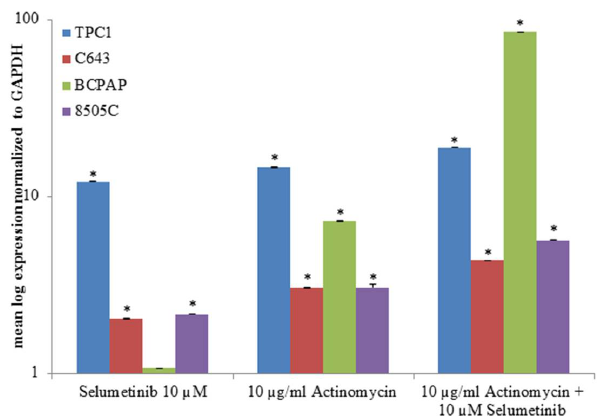
Figure 4. NIS transcript expression after treatment with actinomycin and selumetinib. TPC1, C643, BCPAP and 8505C cells were pre-treated with 10 µg/mL actinomycin for one hour before adding 10 µM selumetinib for 48 h. SLC5A5 was normalized to GAPDH. Results are expressed relative to the untreated control. Data represent mean ± SEM of experiments performed in triplicates. * p < 0.05 regarded as significant.